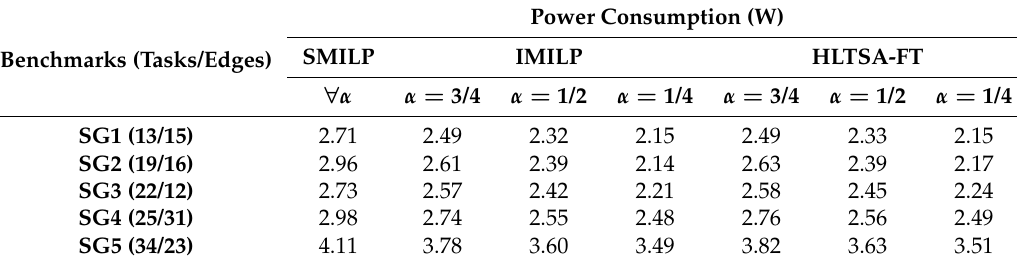
Table 5. Average power consumption under different